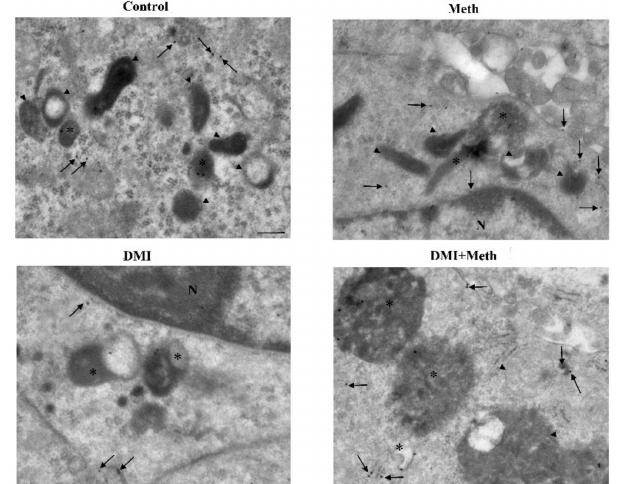
Figure 20. Representative TEM micrograph of LC3 compartmentalization following DMI and Meth (high magnification). Representative TEM micrographs at high magnification of Control, Meth (50 µ M), the selective NET blocker DMI (100 nM), or DMI (100 nM) + Meth (50 µ M)-treated cells. Images show autophagy-like vacuoles (arrowhead); autophagy vacuoles (asterisk for LC3); cytosolic LC3 particles (arrow pointing 20 nM immunogold particles). Cells were fixed for TEM analysis 72 h after Meth administration. In the combined treatment, DMI was administered 45 min before Meth. Scale bar = 200